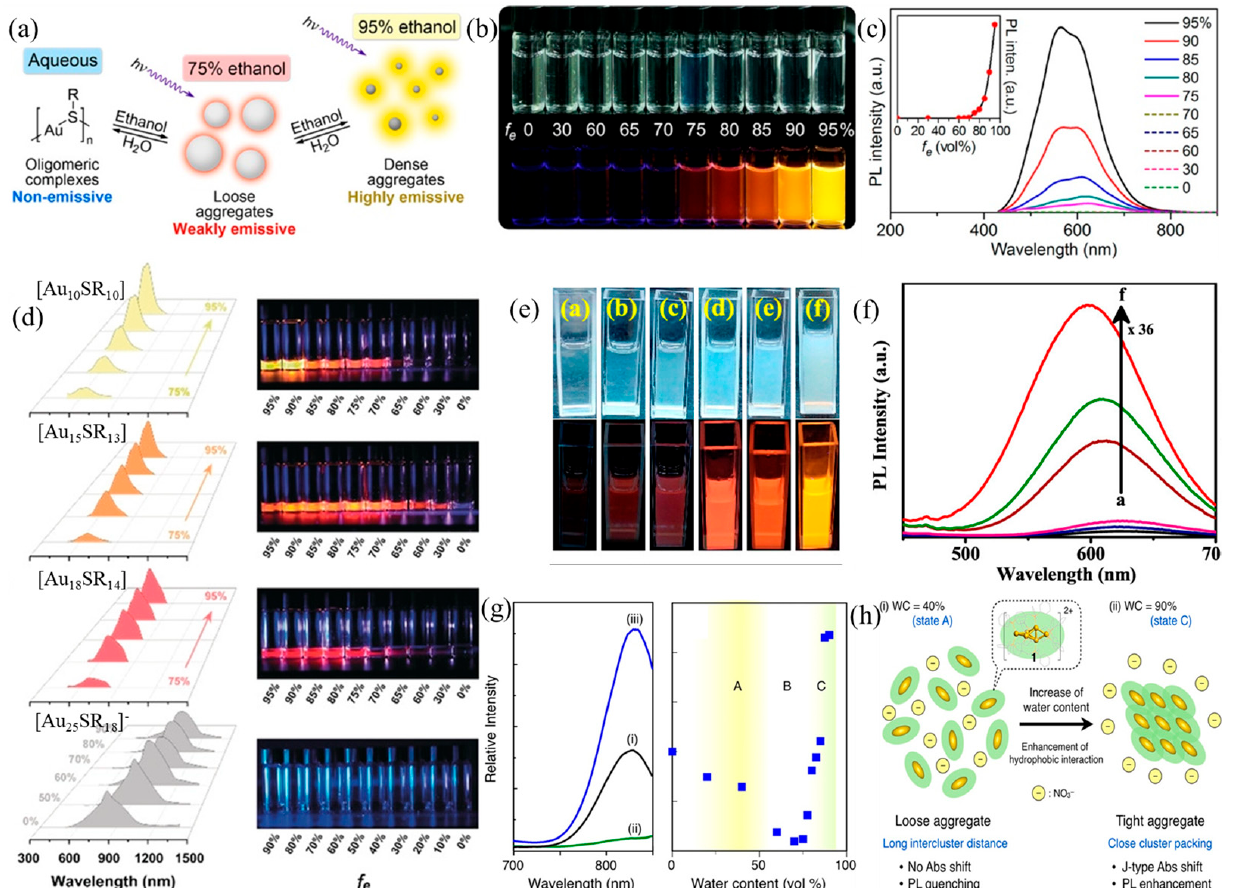
Figure 3. ( a ) Mechanism model of solvent-induced AIE phenomenon of Au(0)@Au(I)-SR NCs. ( b ) Digital photos and ( c ) photoemission spectra of Au(0)@Au(I)-SR with different f e . Reprinted/adapted with permission from Ref. [17]. 2012, copyright American Chemical Society. ( d ) Luminescence spectra ( left ) and the corresponding digital photos ( right ) of Au 10 SR 10 , Au 15 SR 13 , Au 18 SR 14, and [Au 25 SR 18 ] − with a different fraction of ethanol and water. Reprinted/adapted with permission from Ref. [26]. 2020, copyright Wiley-VCH. ( e ) Digital photos and ( f ) PL spectra of Cu 34 − 32 (SG) 16 − 13 with different f e . Reprinted/adapted with permission from Ref. [27]. 2019, copyright American Chemical Society. ( g ) Photoluminescence spectra of (i) MeOH, (ii) MeOH/water (30/70), and (iii) MeOH/water (10/90). ( h ) Mechanism model of possible aggregate forms of MeOH/water at low (i) and high (ii) WC. Reprinted/adapted with permission from Ref. [28]. 2020, copyright American Chemical